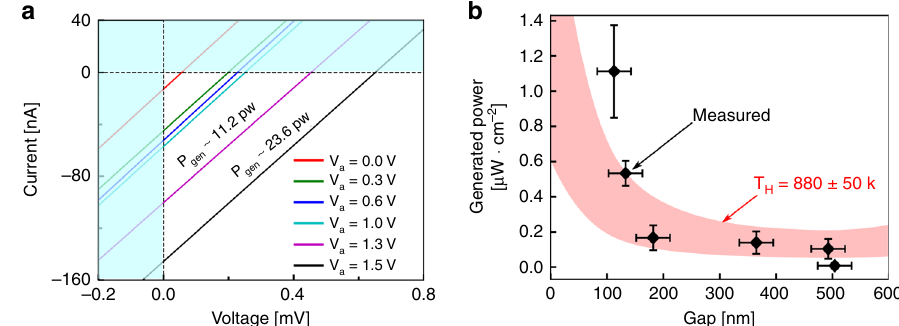
Fig. 4 Characterization of thermo-photovoltaic cell. a Measured change in IV for constant emitter temperature and varying gap achieved by applying NEMS actuation potential ( V a ). The IV curves shift into 4th quadrant representing power generation from the near- fi eld thermal radiation. Farther the shift, more is the power generated. b Measured power density from our thermo-photovoltaic (TPV) cell as a function of emitter-detector gap. The error-bars on x -axis represent the mean error in estimation of displacement while, error-bars on y -axis represent the variation in power measured over two successive measurements on the same device. Also shown is a con fi dence interval of the computed power generation for our TPV cell with independently measured ef fi ciency of our Ge photodetector accounted. The simulation curves also account for the bending of the suspended structure under the in fl uence of actuation potential that is applied to reduce its distance with respect to the underlying photodetector. The simultaneously measured emitter-to-actuator leakage current is found to be <16 pA — nearly four orders smaller than the current measured from the thermal radiation.